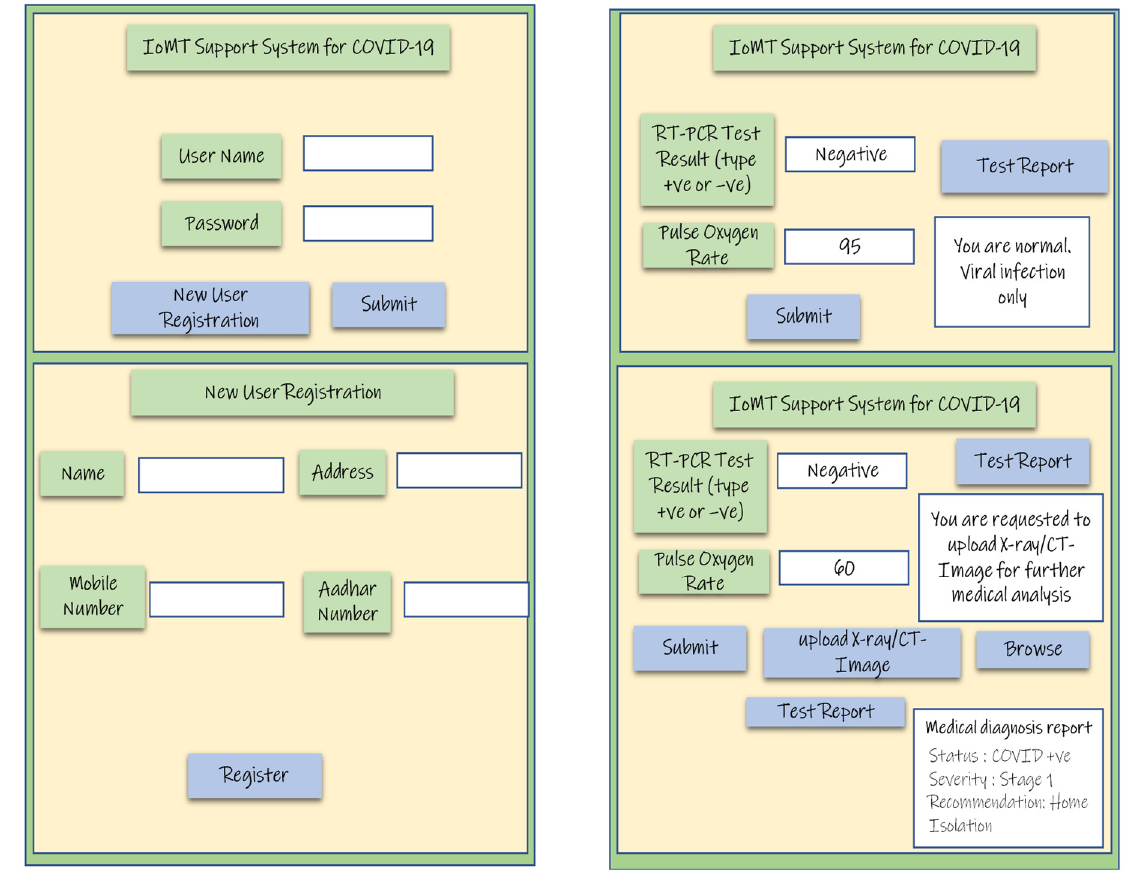
Figure 4. Graphical User Interface design for data acquisition and report generation.